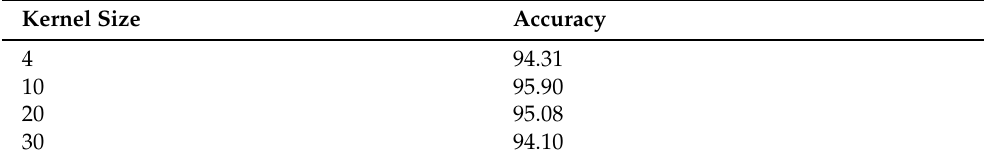
Table 6. Ablation experiments for convolution kernel size on the COSEG vases for segmentation.